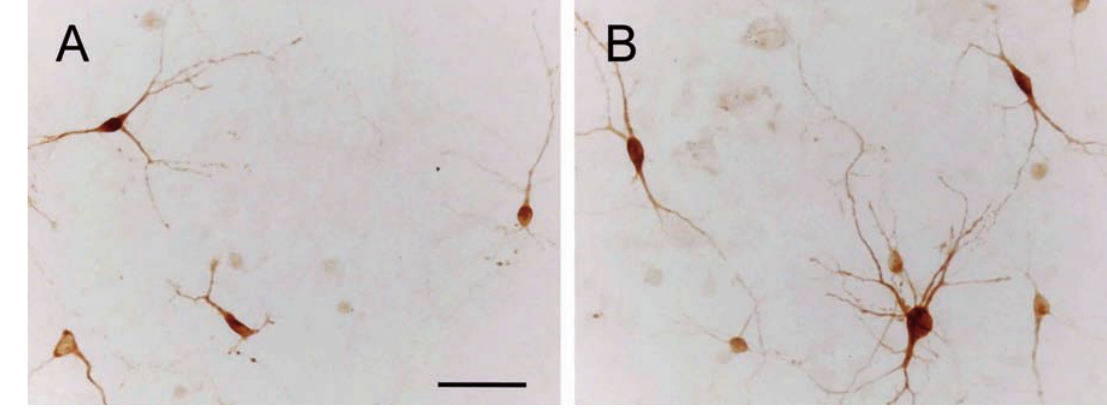
Figure 5 Neuroprotective effects of creatine exposure on densi- ties of dopaminergic neuronal precursors immunostained for the catecholaminer- gic marker tyrosine hydroxylase in mes- encephalic cultures. Cells were grown for 7 days in vitro in ab- sence (A) or presence (B) of creatine [5 mM] in the culture medium. Note the promotion of mor- phological differenti- ation of the neurons after exposure to creatine. Scale bar: 50